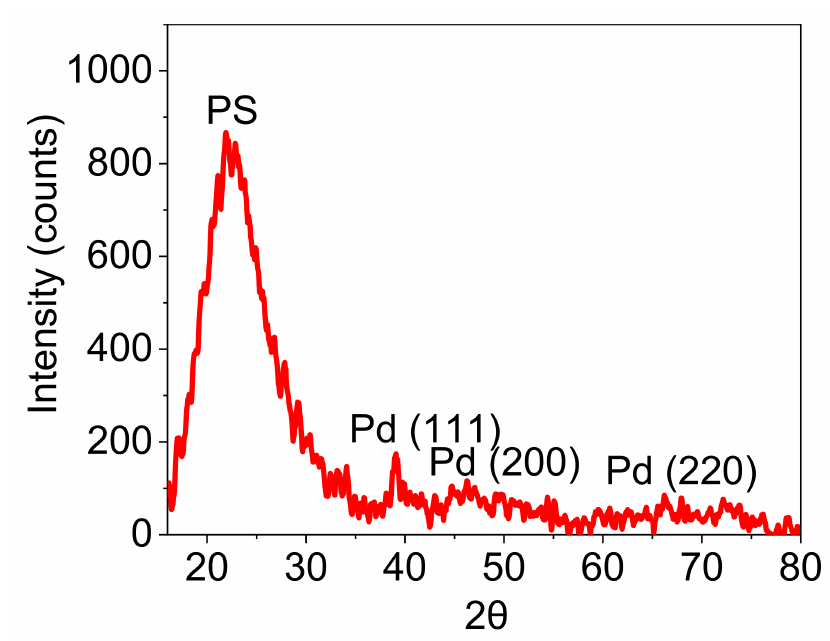
Figure 4. XRD pattern of